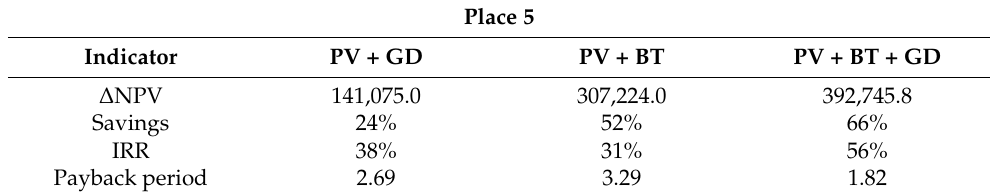
Table 6. Economic indicators influenced by the irradiation level and system configuration,